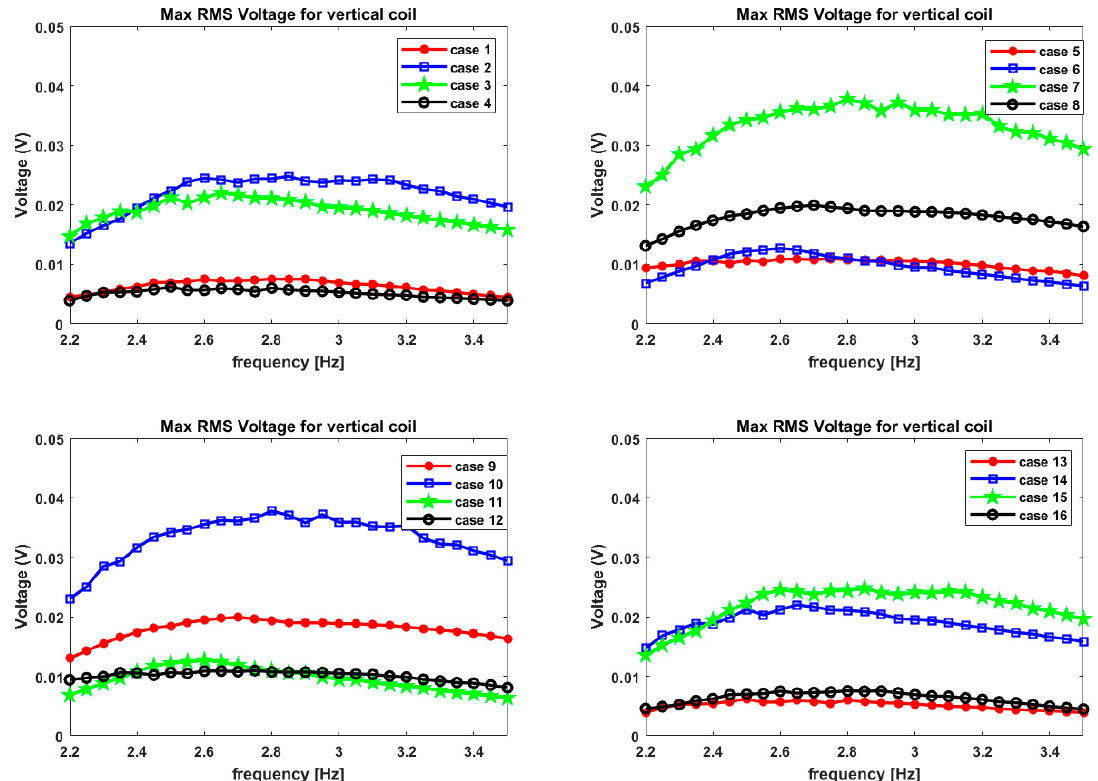
Figure 17. RMS voltage plots for Cases 1–16 while considering vertically wound coil for L = 5 cm tank. Secondly, it is observed that there is a secondary peak that was observed for the L = 10 cm tank near 1.5 Hz for both the horizontal and vertical windings, which does not seem to appear for the L = 5 cm tank. This might be due to the inexistence of any non-linear coupling between the sloshing modes of the system, perhaps due to the reduction in size and the increase in the modal frequency from 2 Hz (for L = 10 cm tank) to 3 Hz (for L = 5 cm tank). The RMS current is calculated by solving for instantaneous current from Equation (22) for all the 9 coils and 25 load resistors to determine the power through the load resis- tor. Then the RMS value of this current is taken, and power through the load resistance is calculated using 𝐈 𝐫𝐦𝐬𝟐 × 𝐑 𝐋 , using the value of RMS current pertaining to that particular load resistor and that particular coil. Then the maxima of the power output for the above 225 cases (i.e., 9 coils and 25 load resistors) is taken for each of the 16 magnet arrangements and all the 27 frequencies. Figure 18 shows the maximum power through the horizontal winding for all 16 cases, and all of the 27 frequencies are plotted.